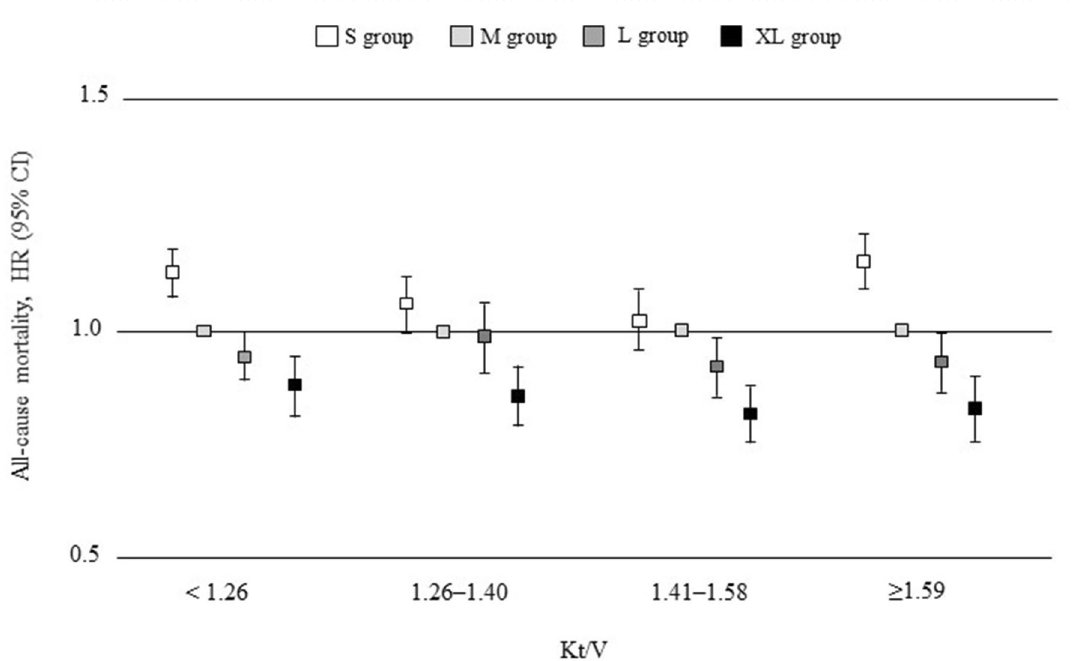
Figure 5. Adjusted hazard ratios for all-cause mortality associated with dialyzer surface area stratified by Kt/V quartile. Squares indicate the adjusted hazard ratios (HRs) for mortality and the error bars indicate the 95% confidence intervals (CIs). The HR for mortality (95% CI) was derived from Cox proportional hazards models adjusted for all covariate values, including basic factors, dialysis-related factors, and nutrition- and inflammation- related factors. S group, small dialyzer surface area, < 1.5 m 2 ; M group, medium dialyzer surface area, 1.5 m 2 ; L group, large dialyzer surface area, 1.6 to < 2.0 m 2 ; XL group, extra-large dialyzer surface area, ≥ 2.0 m 2